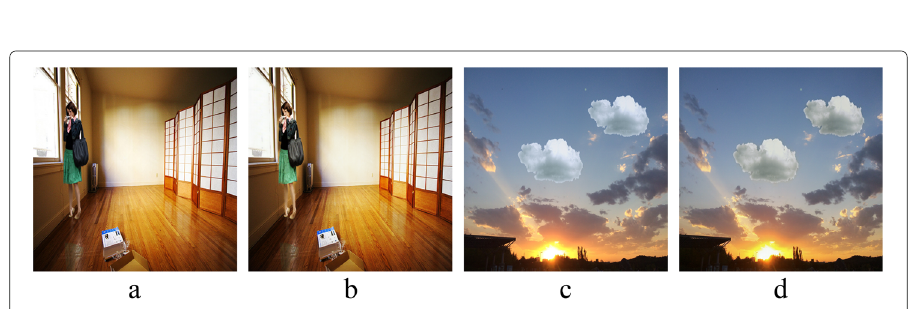
Fig. 16 Failure cases. a Cut-and-paste. b Ours. c Cut-and-paste. d